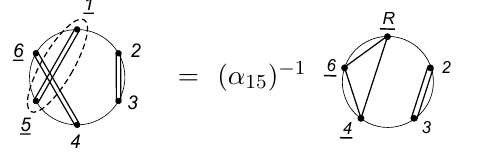
(cid:12) . (cid:12) (cid:12) ( I )